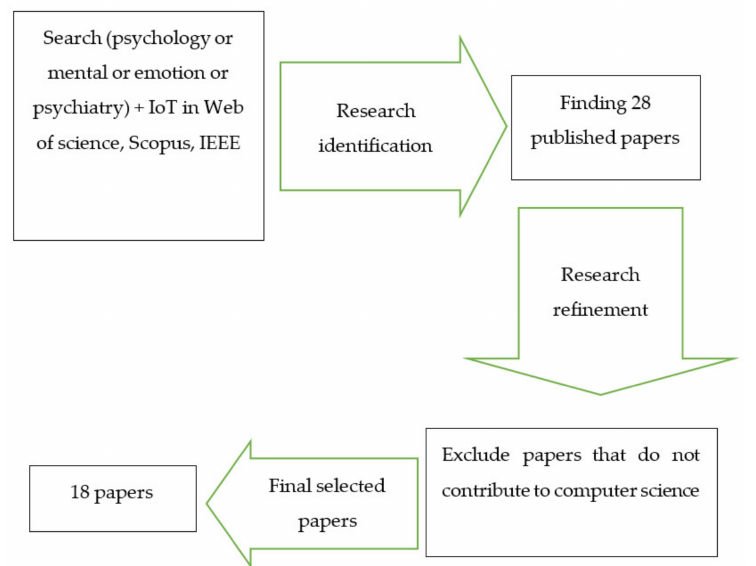
Figure 1. Procedure for selecting the